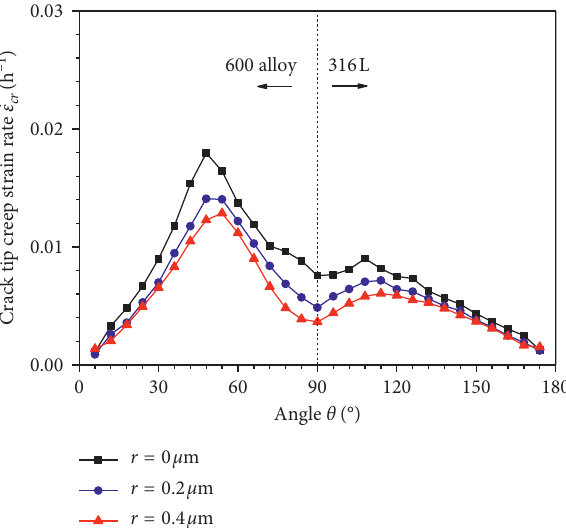
Figure 7: Creep rate of the crack tip with hardening.